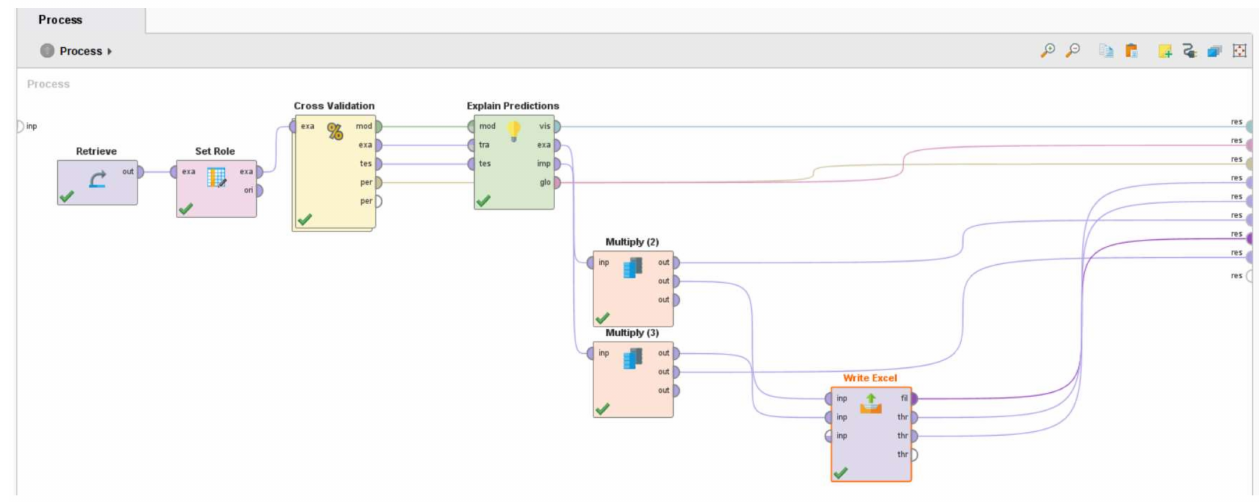
Figure 2. Overview of the ML modelling process using